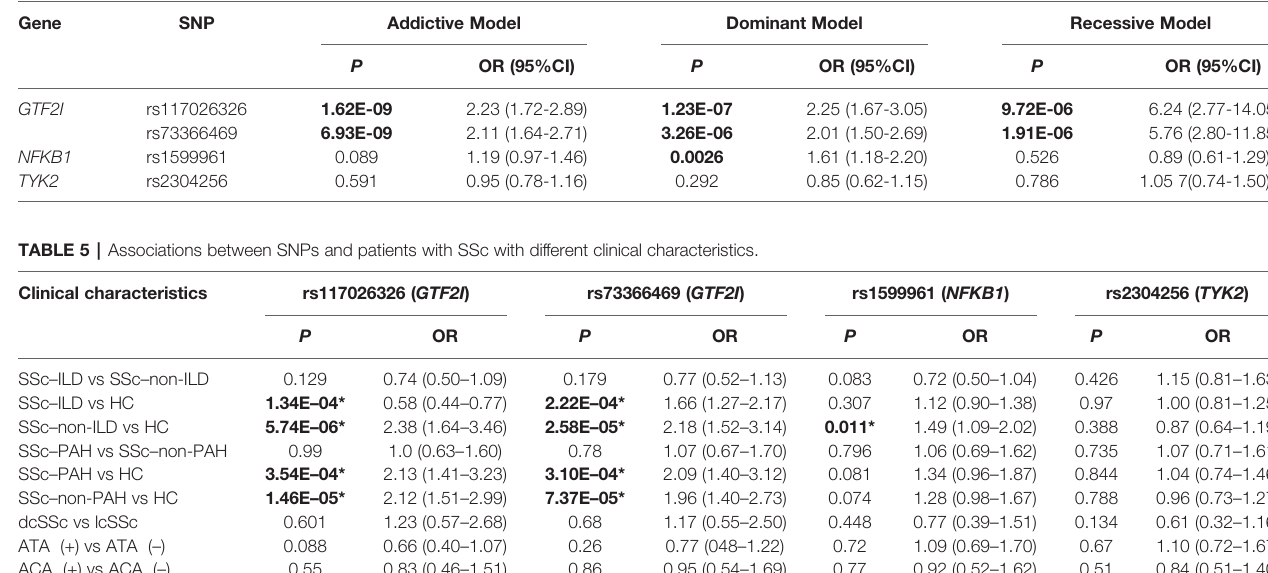
TABLE 4 | Genetic models determined by logistic regression analysis.